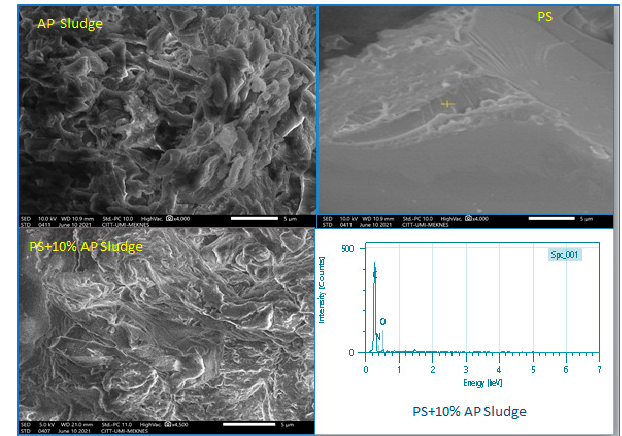
Figure 10. SEM-EDS of AP sludge, PS, and of PS/10%wt AP sludge.